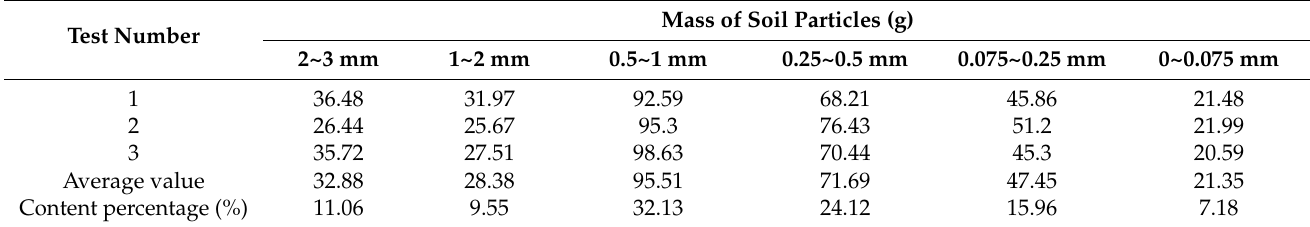
Table 1. Mass distribution of soil particles in different particle size ranges.